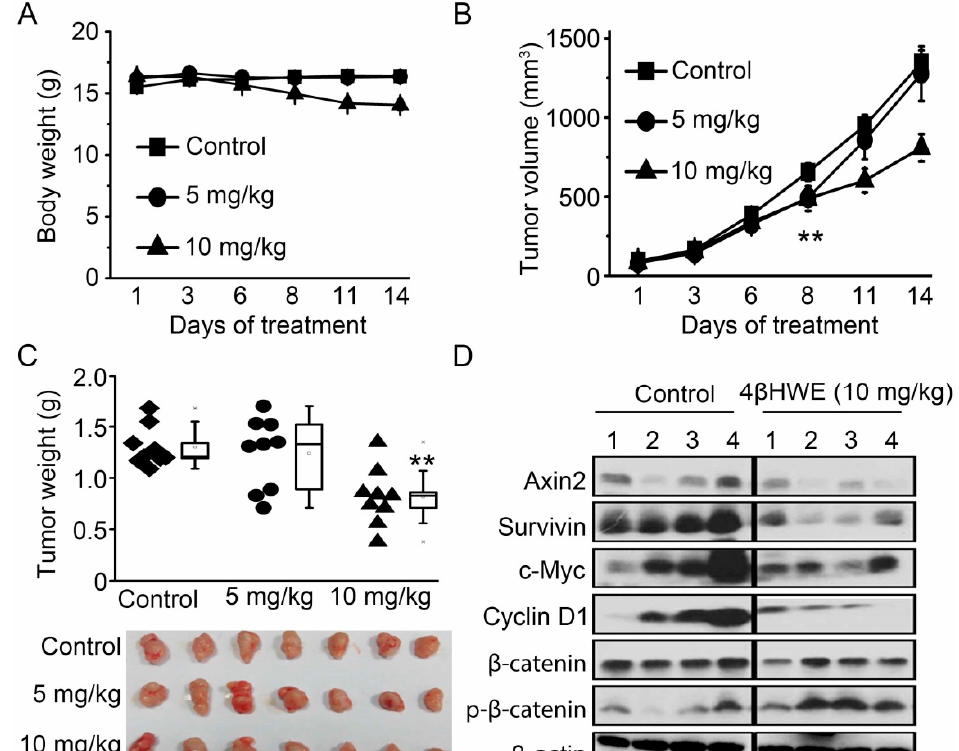
Figure 6. 4 β HWE inhibits tumor growth of in vivo HCT116 xenograft through Wnt signaling. ( A ) 4 × 10 6 HCT116 cells were injected into BALB/c-nude mice, and normal saline was given as a control or 4 β HWE was injected at a dose of 5 mg/kg and 10 mg/kg/day for 14 days. The body weight was measured as the treatment started. ( B ) The individual HCT116 xenograft tumor volume was monitored. ( C ) The weight of each tumor was measured on the 14th day, and the average tumor weight was calculated. The representative external appearance of the tumors are shown upon normal saline or 4 β HWE treatments. ( D ) The effect of 4 β HWE on the expression of Wnt-related proteins in tumor tissues was determined by western blot analysis.